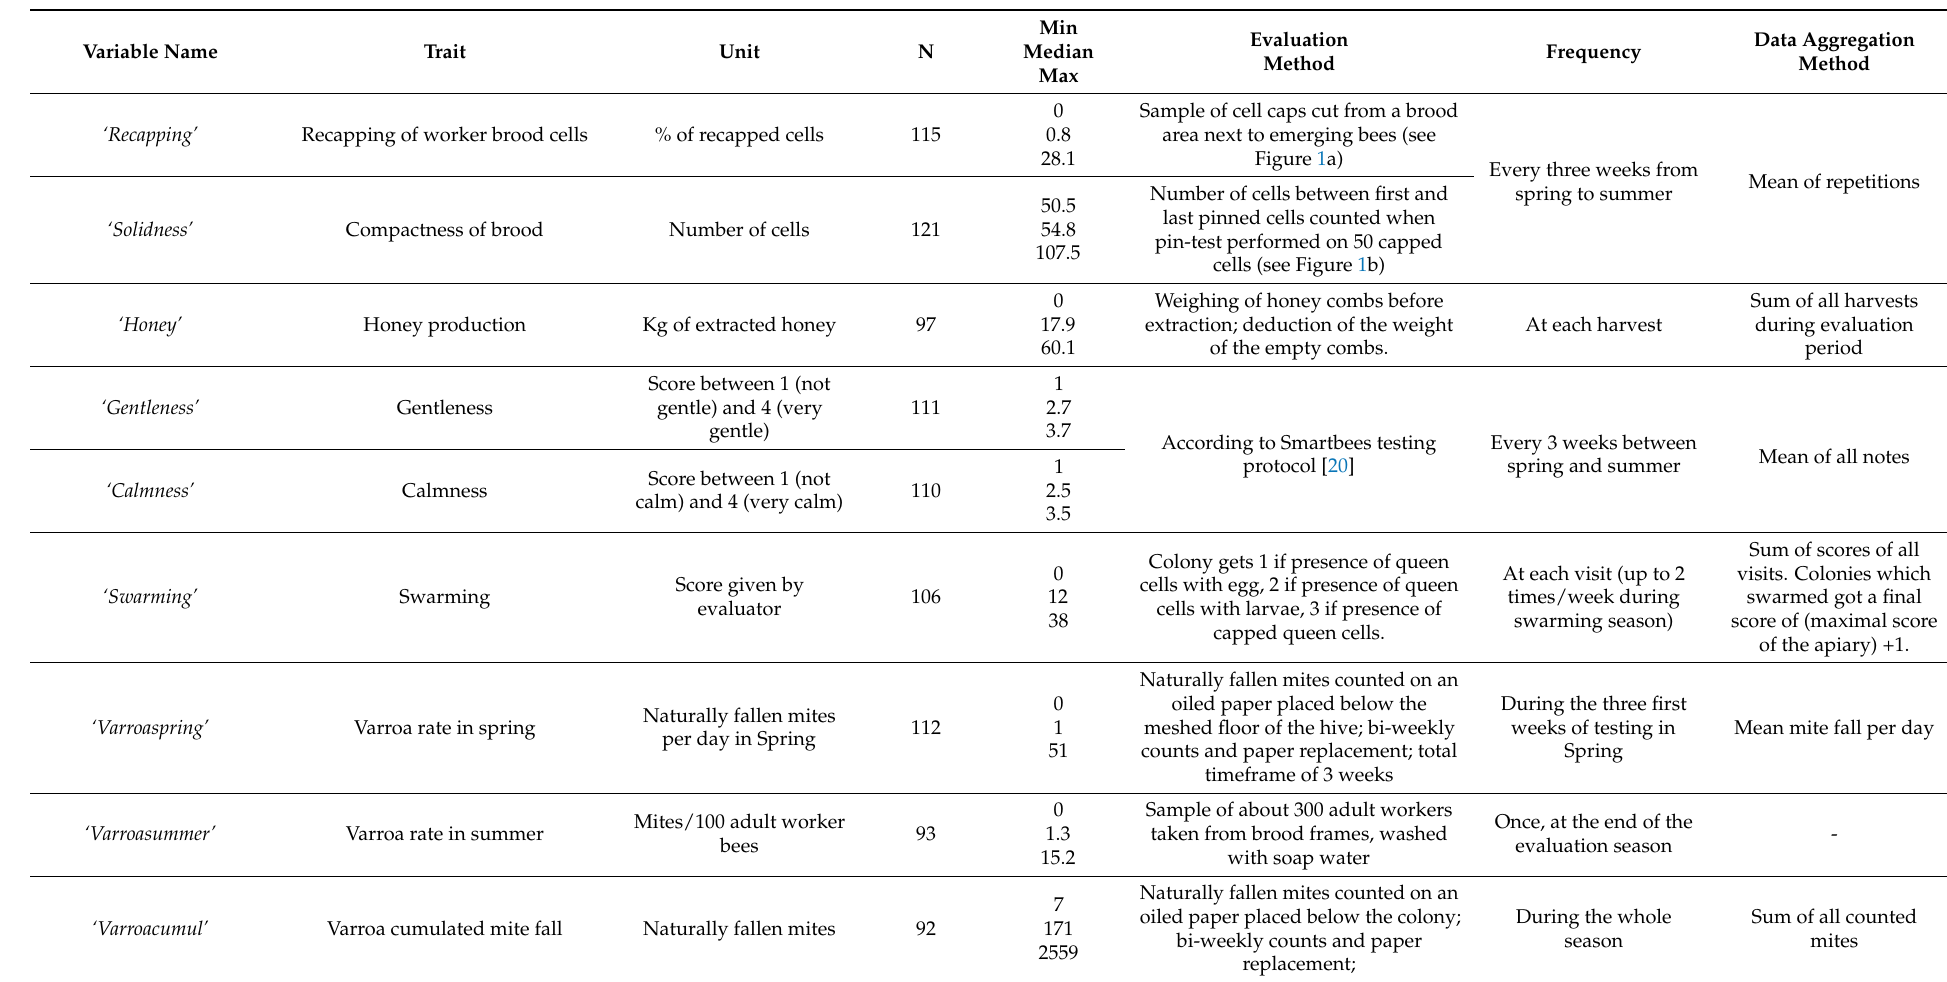
Table 1. Traits recorded in the framework of the colony performance testing protocol at the experimental